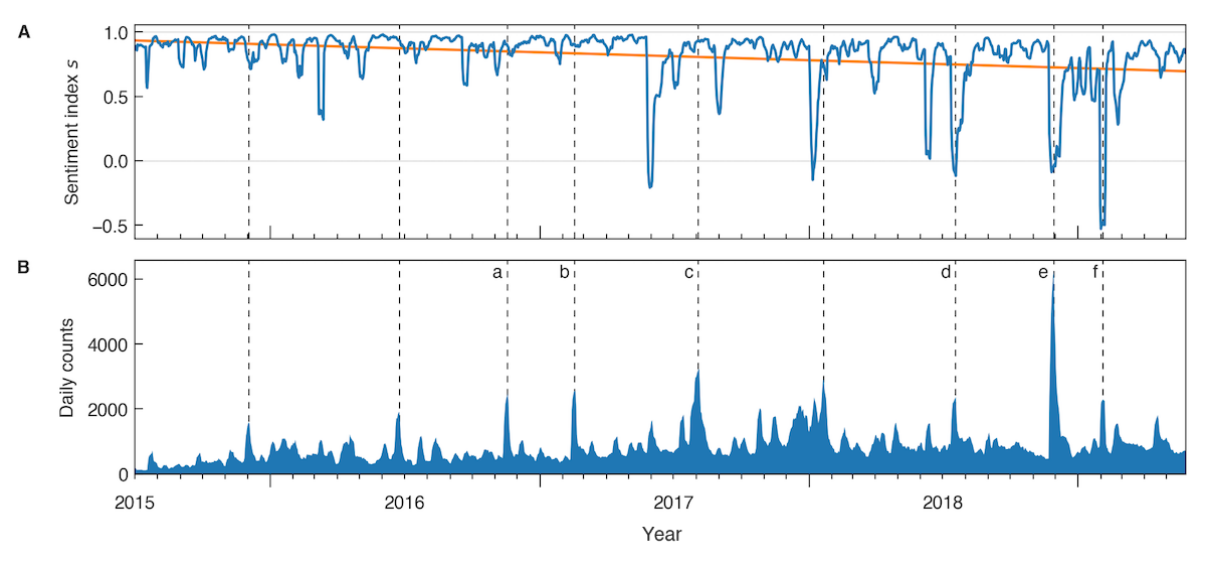
Figure 2. A) Predicted sentiment towards CRISPR between July 2015 and June 2019. The blue curve denotes the sentiment s, which is calculated as the mean of the weighted counts of positive and negative tweets over a centered rolling window of 7 days. The orange curve denotes a linear fit of the sentiment s. B) Daily counts of all analyzed tweets. The blue area shows the daily sum of positive, negative, and neutral tweets as the mean within a 7-day centered rolling window. All peaks above a relative prominence of 0.2 are marked with dashed lines; a-f denote peaks that coincide with certain